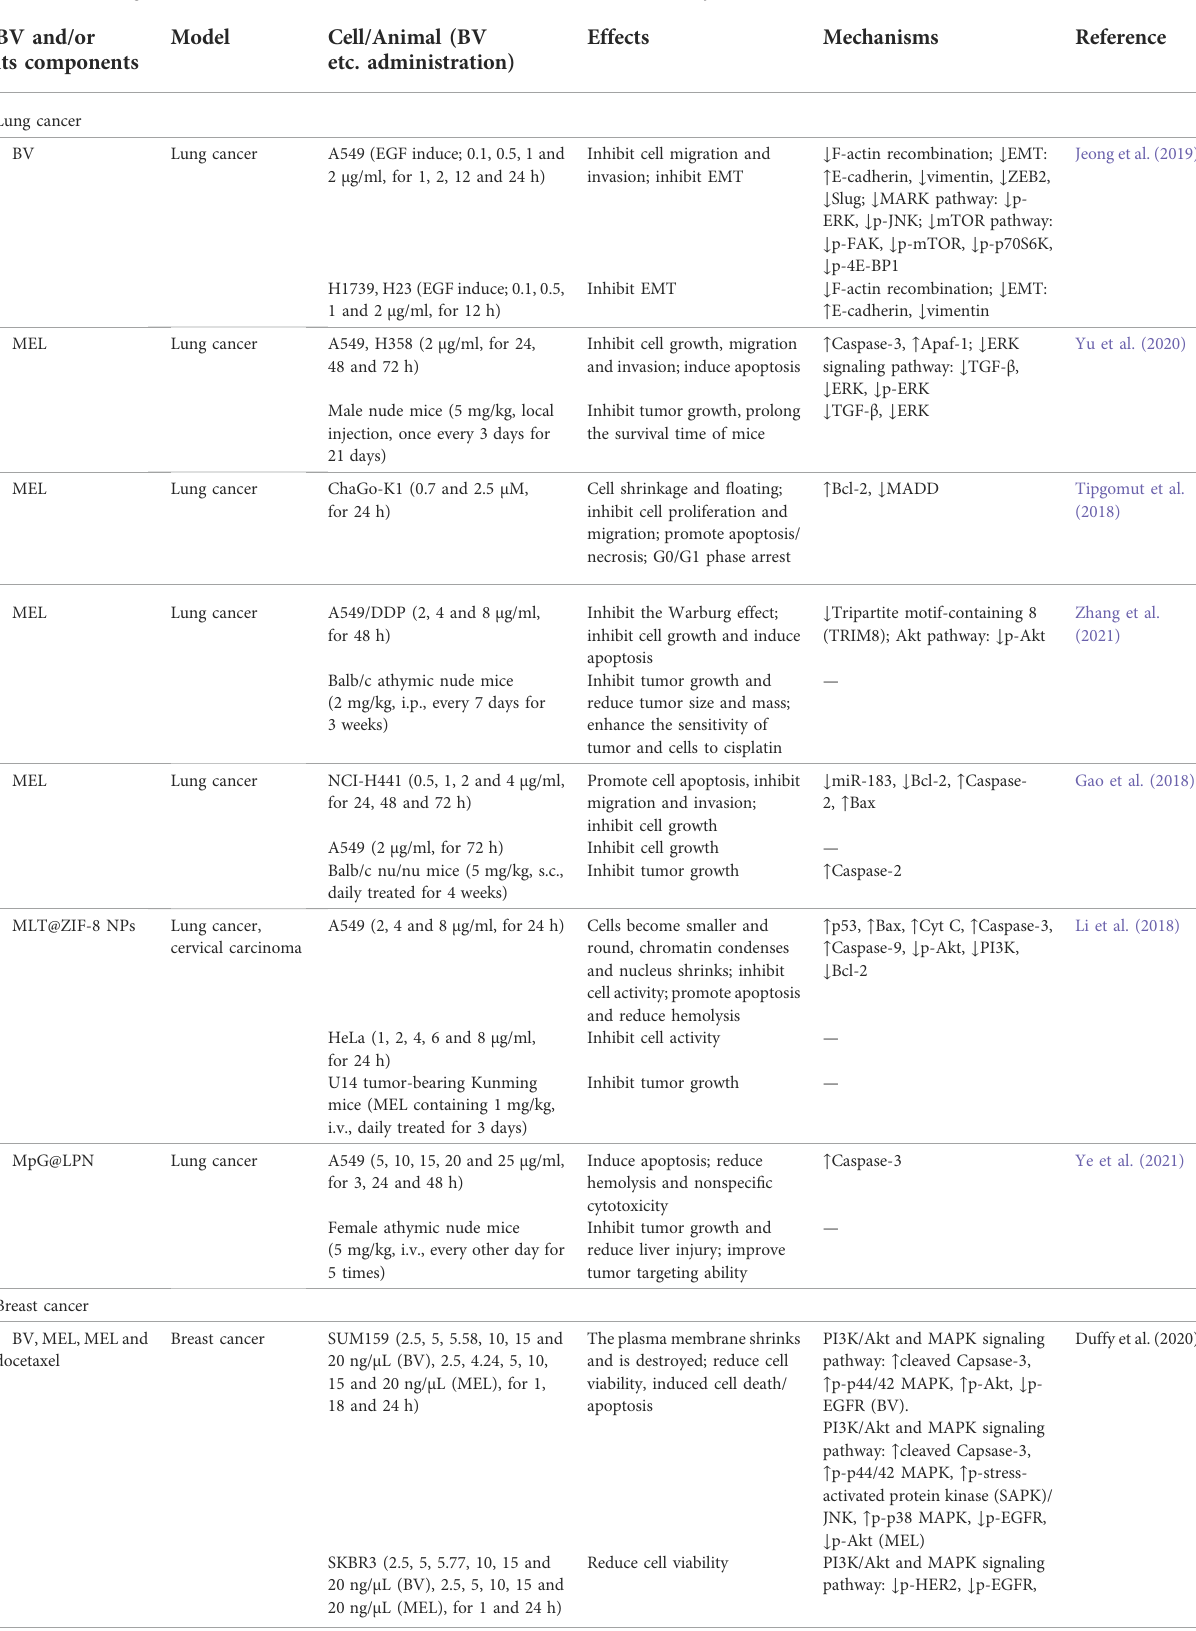
TABLE 1 Summary of the anti-cancer effects and mechanisms of BV and its main components. BV and/or its